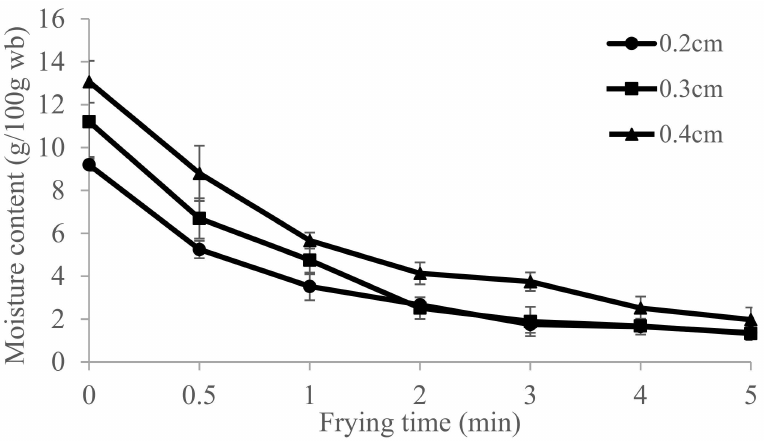
Figure 1. The moisture content (wet basis) of fried pork skins were determined every min for 5 min at 105 ◦ C drying using a convection oven. ( n = 3; p < 0.05).